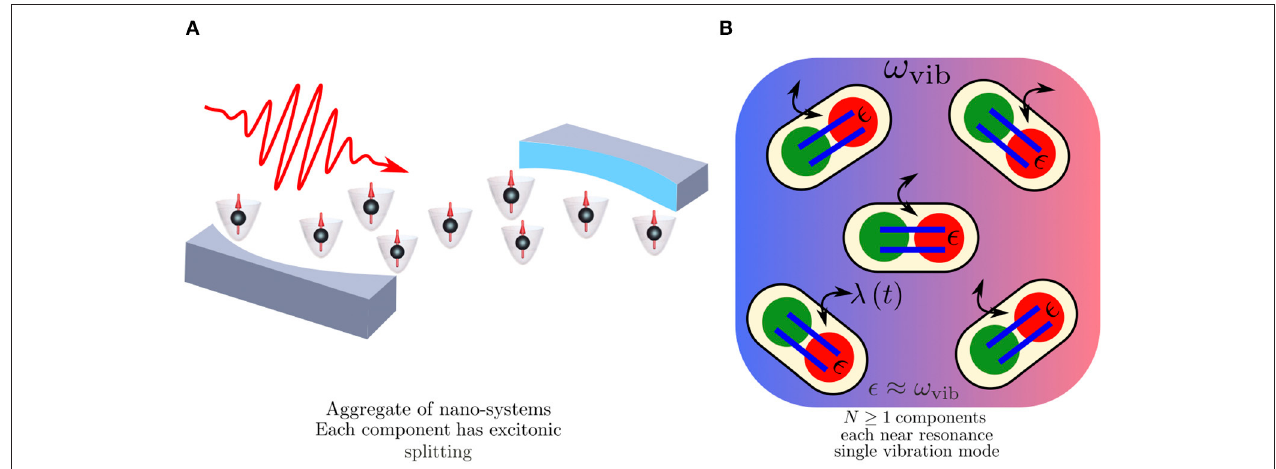
FIGURE 1 | (A) Prototype system. As an illustration of how our general model and results might be applied in the future, this schematic diagram indicates the type of system that could mimic the dynamics that we analyze for N qubits immersed in a single-mode bosonic environment. We stress that similar implementations have already been built experimentally within the atomic physics community. (B) Schematic representation of the single mode, resonant version of our model (Equation 1). Though it is not our intention to accurately describe any one implementation, we note that in the possible setting of light harvesting/processing in biochemical systems, each qubit or dimer in (A) comprises two split excitonic energy levels with separation ǫ which can be regarded as the basic two-level component in our N -component system. The coupling ( λ ( t )) is time-dependent in order to capture the complex swathe of additional non-equilibrium, anharmonic interactions that can be generated in the system by an external pulsed